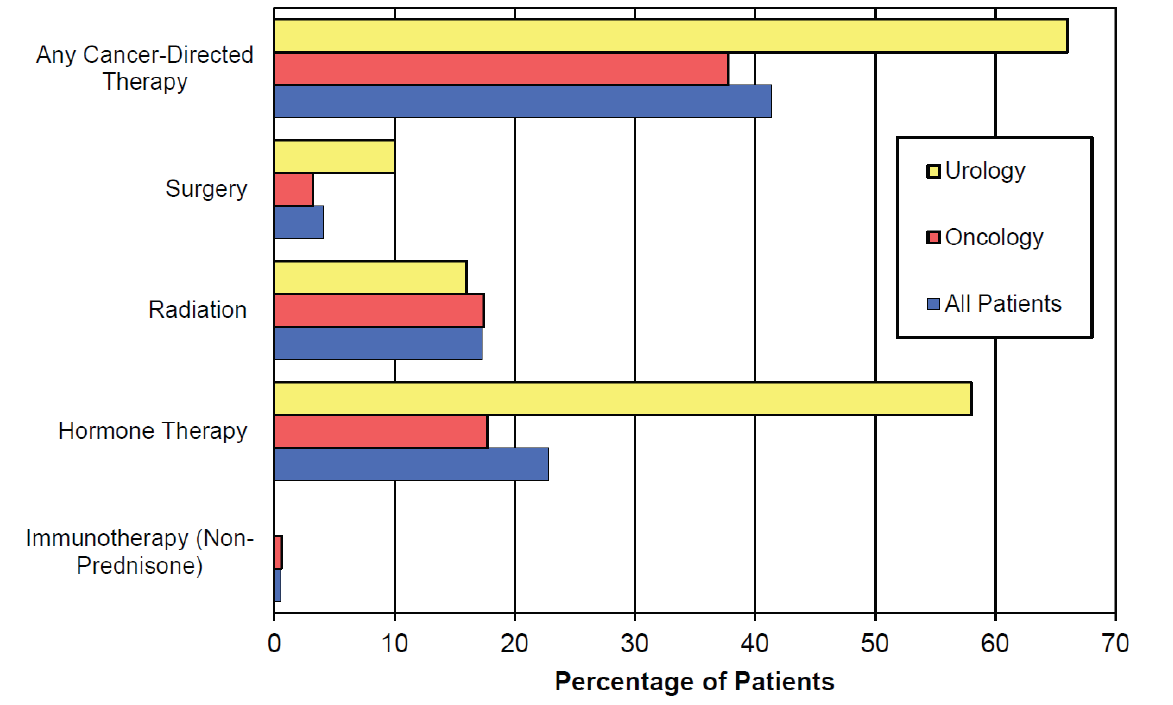
Figure 2. Other Cancer-Directed Treatments Received in Combination with Docetaxel, by Specialty of Treating